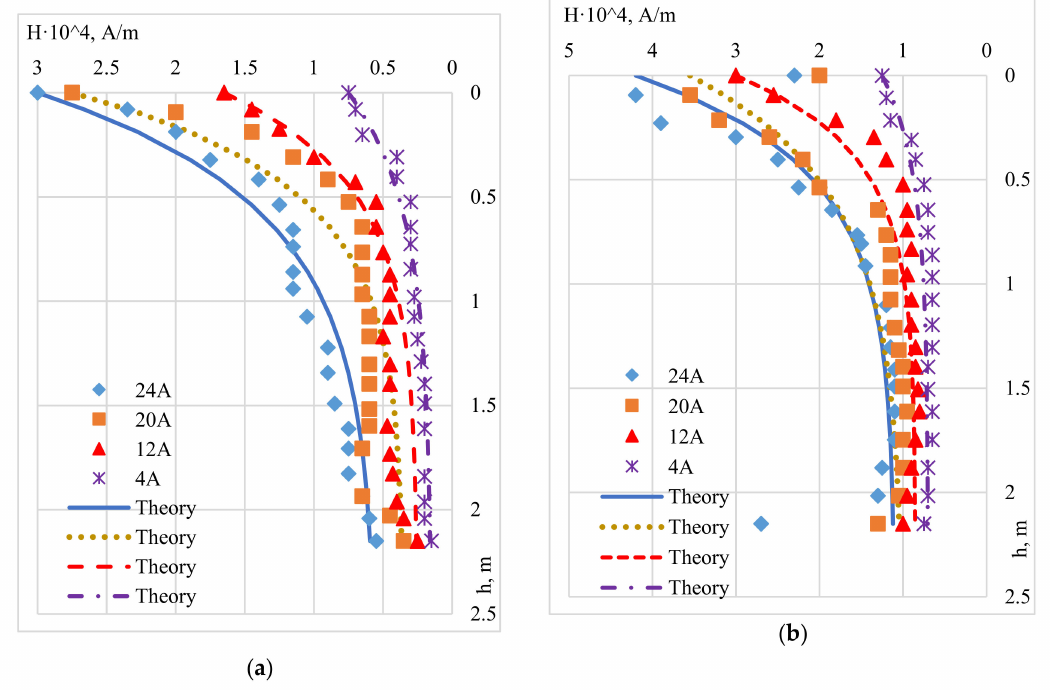
Figure 8. The distribution of the magnetic field in an electromagnetic hydrocyclone on the outer surface of the outlet pipe ( a ) and the inner surface of the hydrocyclone body ( b ) at di ff erent currents.